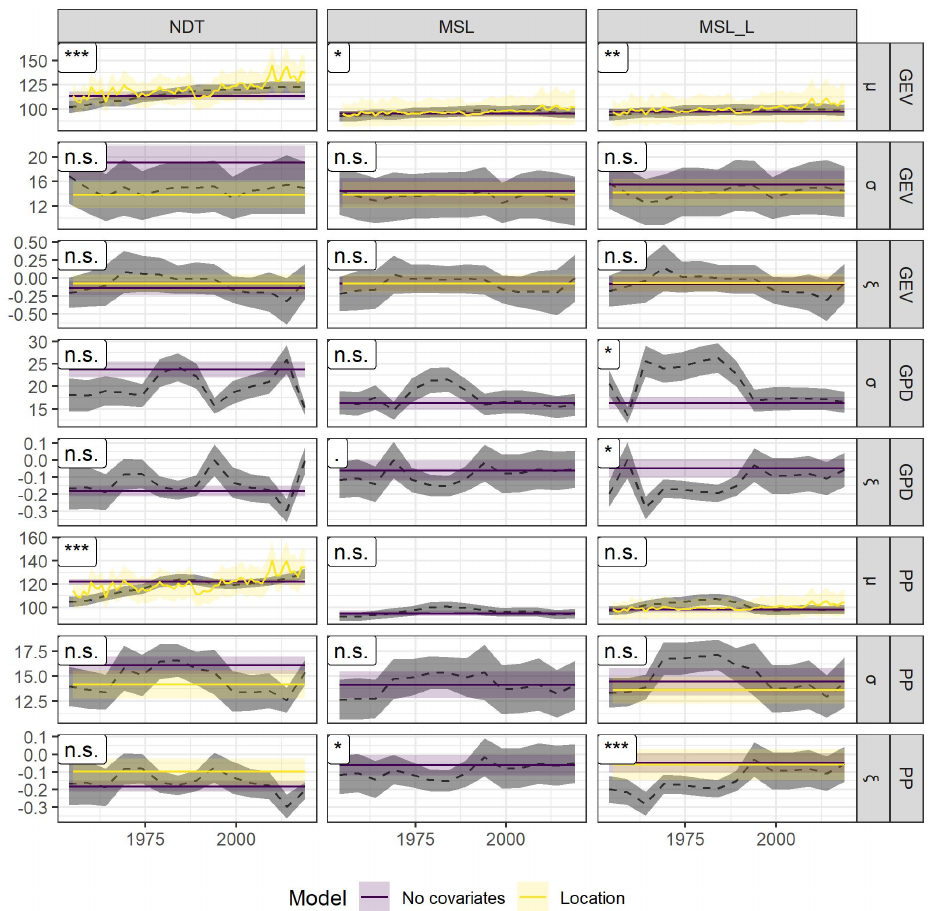
Figure 3. Comparison between the parameters estimated in the time window analysis (dashed line; the grey envelope represents the un- certainty in the parameters from the time window analysis) and the parameters estimated by different model configurations over the full data record length. Here only results for Venice are reported; see Fig. S3 for Marseille. Parameters from all the configurations of the GEV, GPD, and PP models that do not include covariates are shown. Parameters from models with covariates are shown only if models improve significantly the fit (see Table 2 for the likelihood ratio test). The shape ξ is included in the figure, but no covariate dependence was tested for this parameter. The horizontal axis represents the final year of the time window. Plots are grouped vertically according to the detrending method (MSL: mean sea level; MSL_L: long-term mean sea level; NDT: non-detrended) and horizontally according to the distribution func- tion (GEV: generalized extreme value; GPD: generalized Pareto distribution; PP: point process). The text in the label in the top left corner of each plot shows the significance level of the Mann–Kendall trend test on the parameters from the time-window analysis (n.s.: non-significant; .: p < 0.1; ∗ : p < 0.05; ∗∗ : p < 0.01; ∗∗∗ : p <